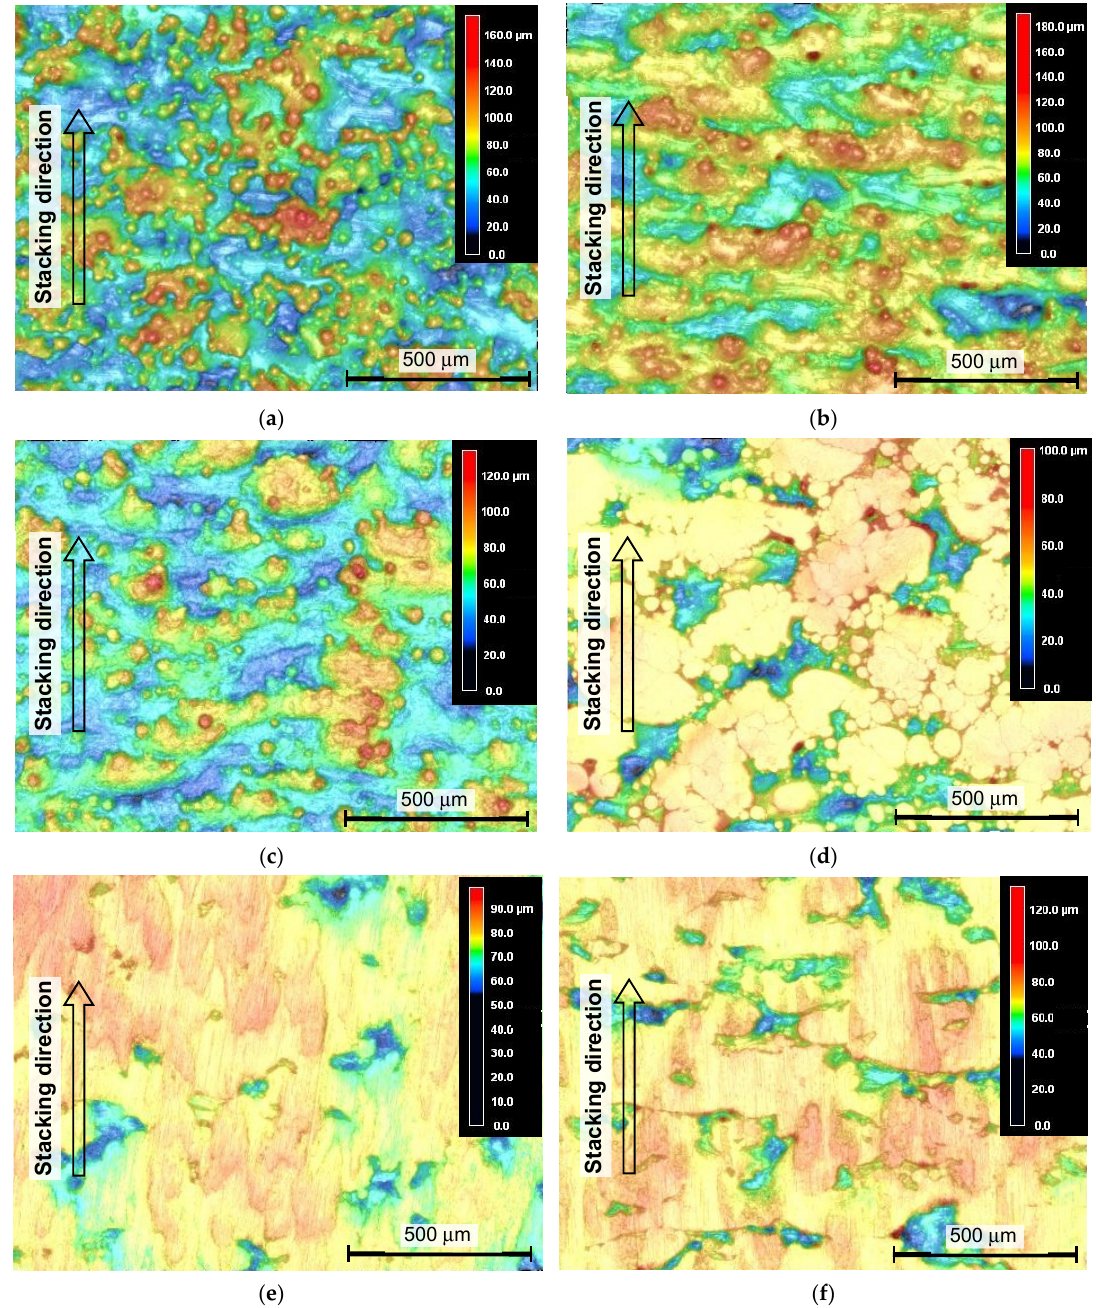
Figure 5. Aspects of the specimen manufactured by DMLS, observed by a laser confocal microscope. ( a ) As-built; ( b ) cavitation peening; ( c ) laser peening; ( d ) shot peening; ( e ) grinding; ( f ) grinding and cavitation peening.